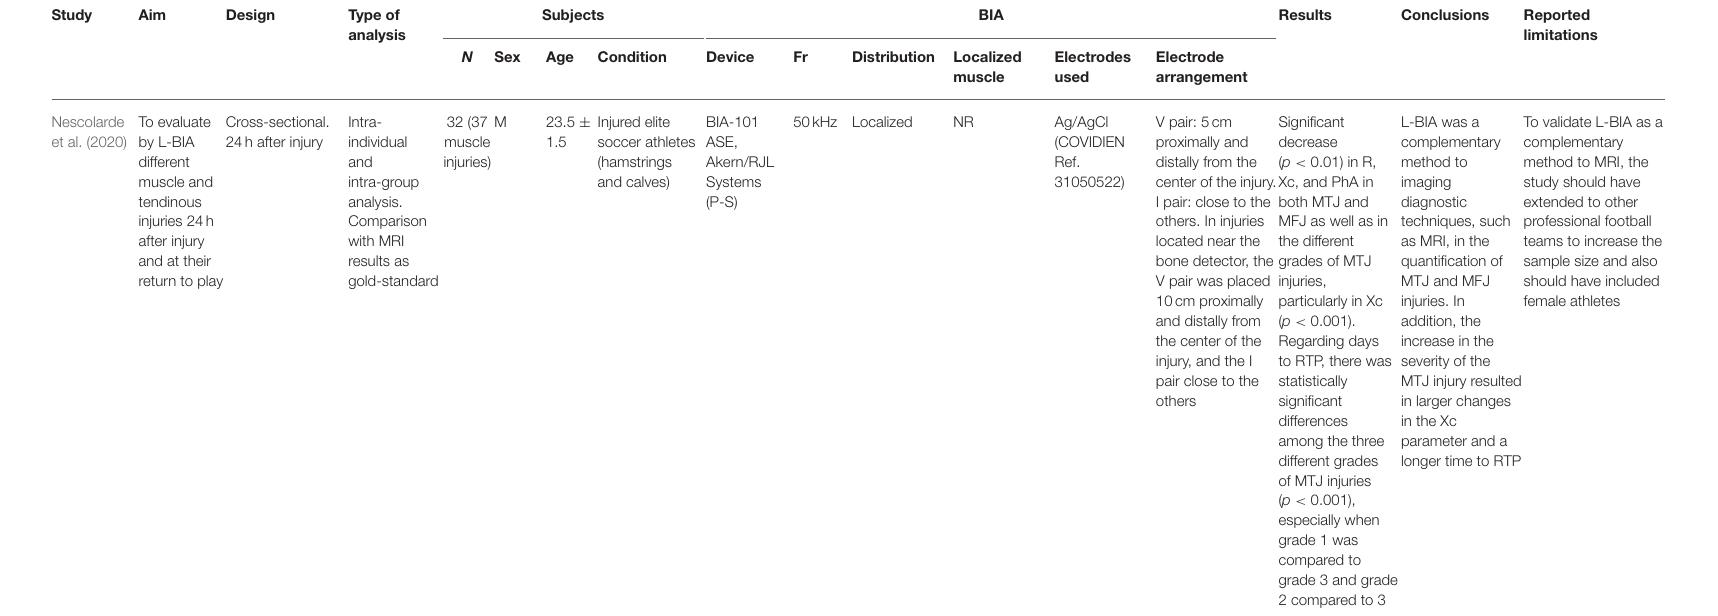
V pair: 5cm proximally and distally from the center of the